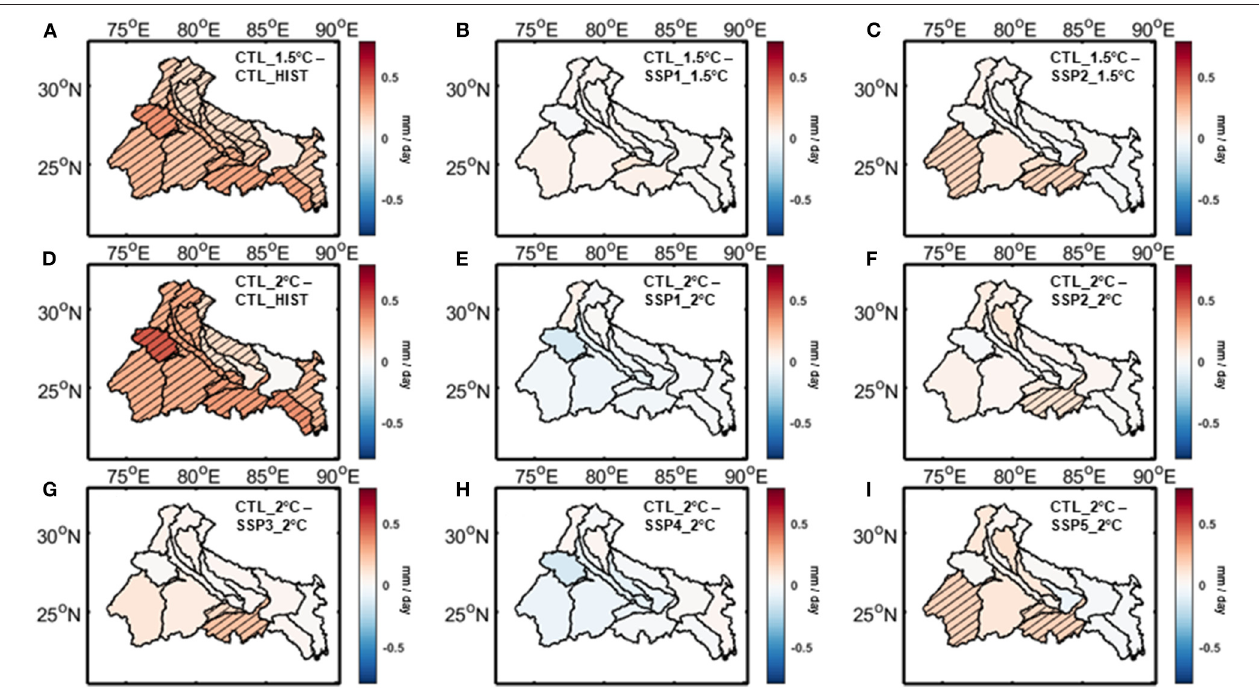
FIGURE 9 | Changes in VIC simulated potential evapotranspiration associate with climate change for (A) 1.5 ◦ C warming, (D) 2 ◦ C warming and land use change for (B) SSP1_1.5 ◦ C scenario, (C) SSP2_1.5 ◦ C scenario, (E) SSP1_2 ◦ C scenario, (F) SSP2_2 ◦ C scenario, (G) SSP3_2 ◦ C scenario, (H) SSP4_2 ◦ C scenario, (I) SSP5_2 ◦ C scenario over Ganga river basin. Hatched regions denote areas with statistically significant changes.